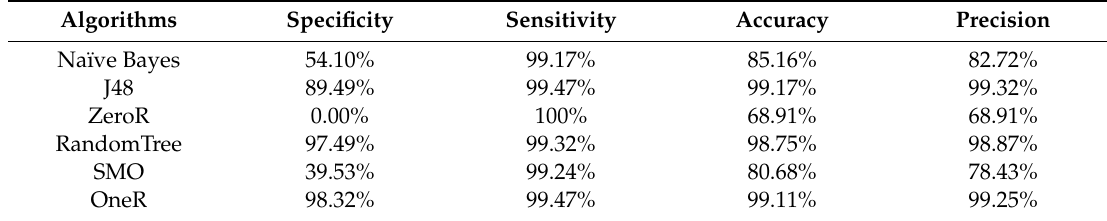
Table 7. Comparison of sensitivity, precision, accuracy, and specificity.